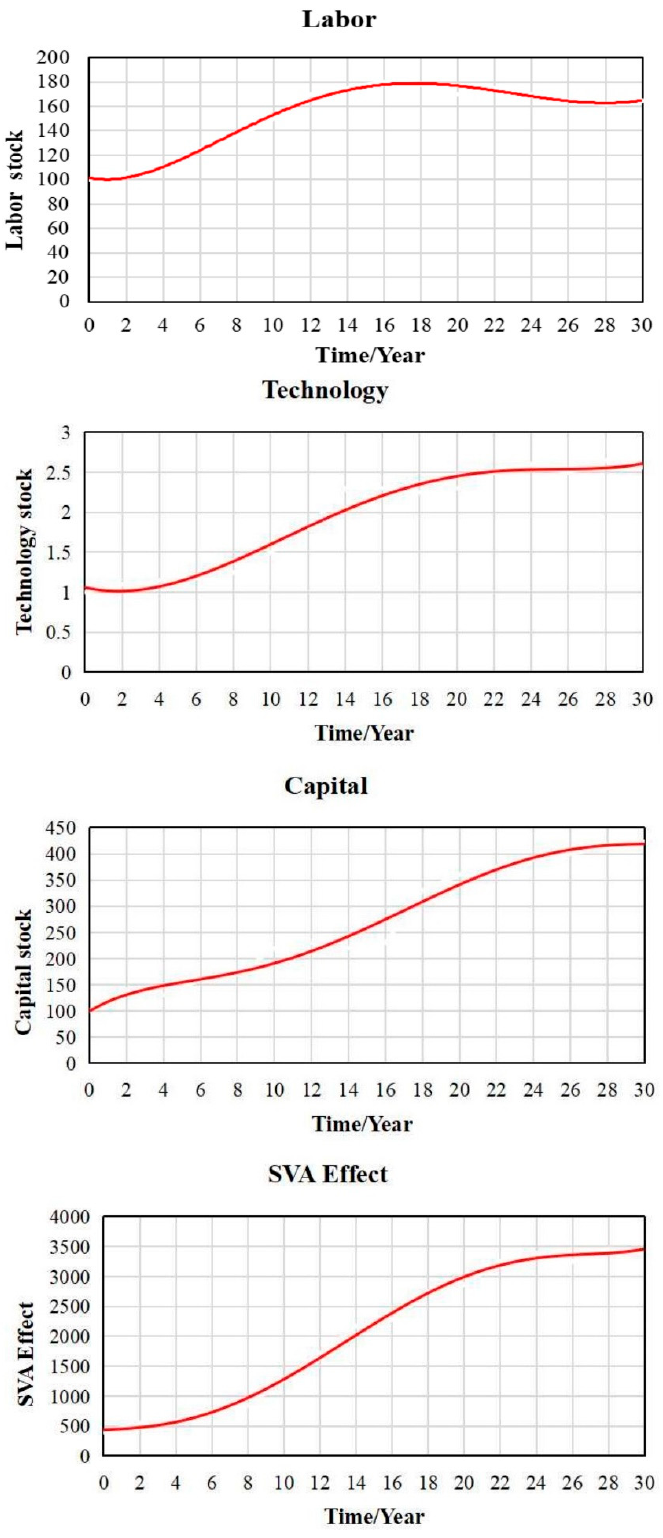
Figure 8. Simulation and prediction results. The Y axis has no units. Y axis indicates the degree, which is a unitless dimension.